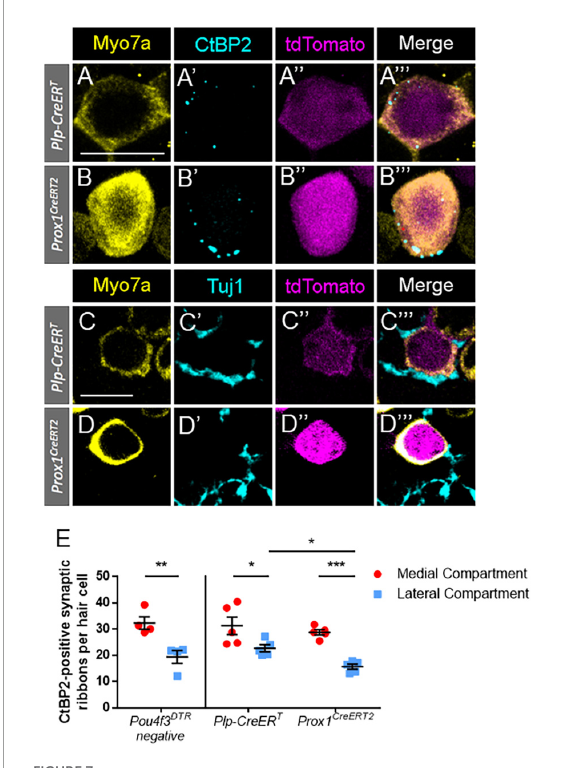
FIGURE7 Regenerated hair cells formed ribbon synapses and were innervated by Tuj1-positive neurites at P7. (A–D”’) Representative confocal slice images from the apical turn of Plp-CreER T :Rosa26 tdTomato :Pou4f3 DTR (A–A”’,C–C”’) and Prox1 CreERT 2 :Rosa26 tdTomato :Pou4f3 DTR (B–B”’,D–D”’) mice at P7–P8 that were injected with tamoxifen at P0 to induce tdTomato expression in the two supporting cell subpopulations and with DT at P1 to induce hair cell damage. Samples were immunostained with anti-Myo7a antibodies (yellow) to label hair cells and anti-CtBP2 antibodies (blue, A–B”’ ) to label synaptic ribbons or anti-Tuj1 antibodies (blue, C–D”’ ) to label neurites of the spiral ganglion. tdTomato was detected using endogenous fluorescence (magenta). Scale bars: 10 µ m. (E) In the Pou4f3 DTR -negative controls, there were significant more ribbon synapses in the inner hair cells located in the medial compartment (red circles) than the outer hair cells located the in the lateral compartment (blue squares). For the DTR:Prox1 CreERT 2 and DTR:Plp-CreER T mice, hair cells were classified as located in the medial or lateral compartment based on their location relative to the tunnels of Corti (see Figures 6A–A”’,C–C”’ ). Similar to the control